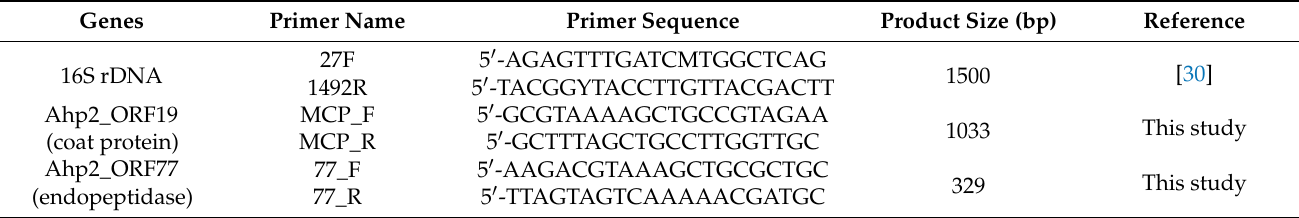
Table 2. PCR primers used in this